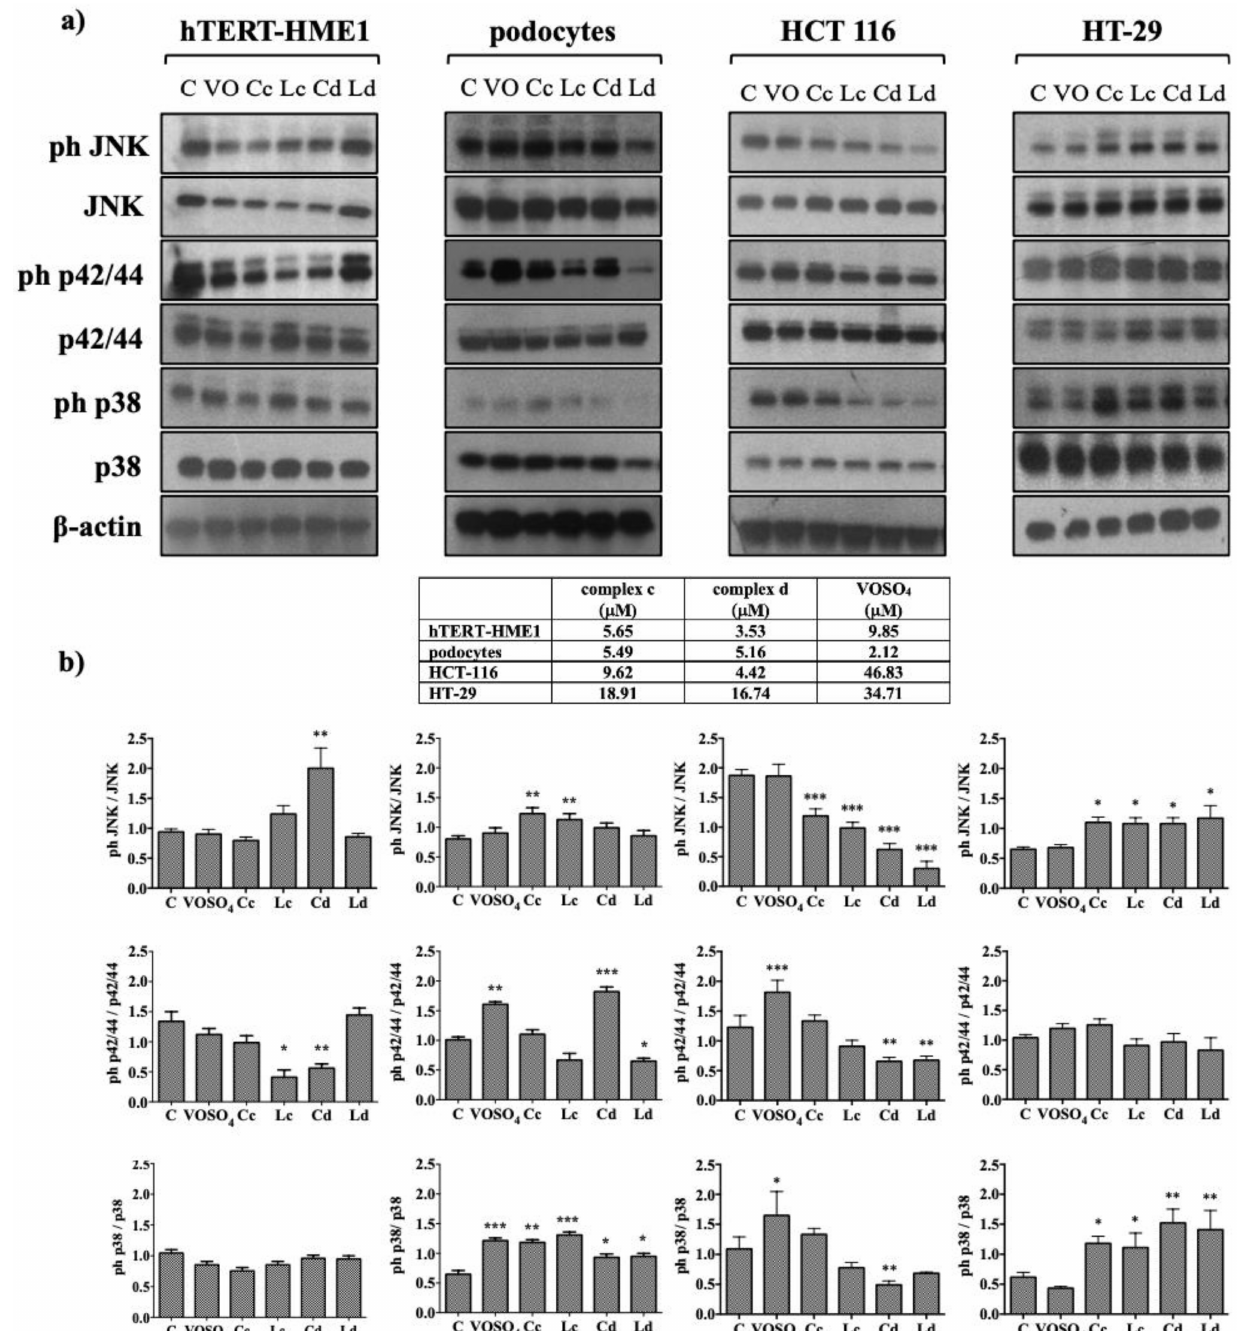
Figure 5. Modulation of MAPKs by vanadyl complexes. Phosphorylation of MAPKs was evaluated via immunoblot analysis. Cells were treated with complexes, ligands, or VOSO 4 for 30 min. All compounds were used at the IC 50 calculated from the antiproliferative assay, and ligands were used at the same concentrations of the respective complex. VOSO 4 was used at the IC 50 calculated from the previously conducted antiproliferative assays or at the maximum concentration if the 50% of proliferation inhibition was not reached. The used concentrations are reported in the table presented in the figure. ( a ) Phosphorylation of MAPKs proteins was evaluated via immunoblot analysis. β -actin was used to confirm the homogeneity of the protein loaded. Immunoblot was representative of three performed experiments. ( b ) Densitometric analyses were performed using ImageJ. Values are presented as the means ± S.D.; n = 3; * p < 0.05, ** p < 0.01, *** p < 0.001 vs. control (C). VO: VOSO 4 , Cc: complex c, Cd: complex d, Lc: ligand c, Ld: ligand